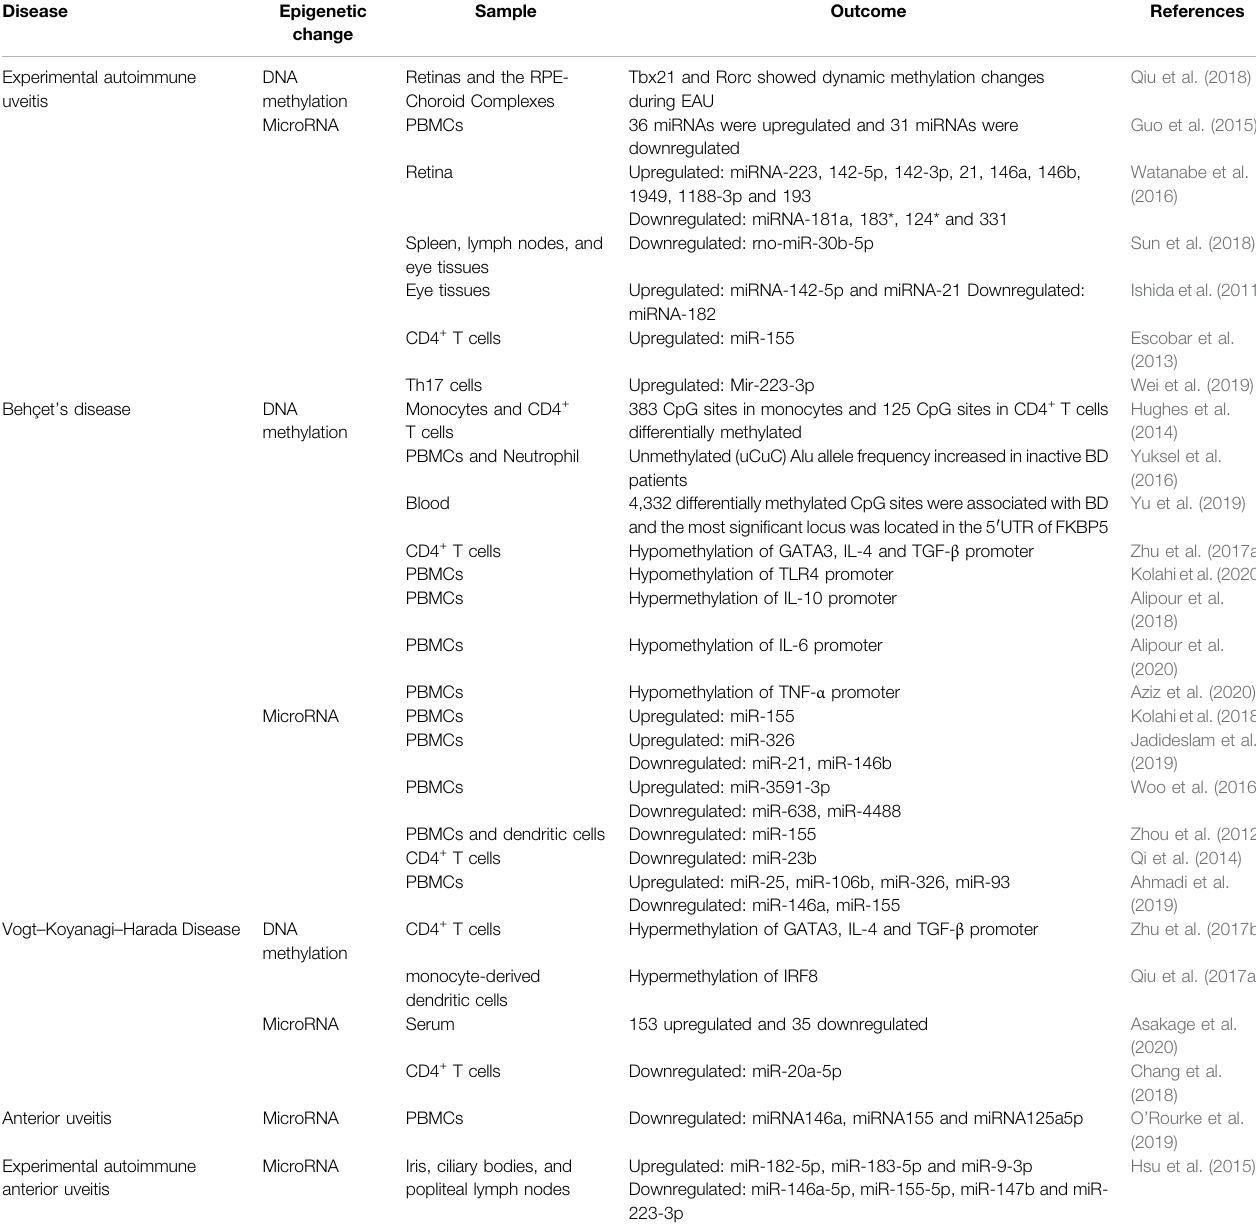
TABLE 1 | Epigenetic alterations in Uveitis.